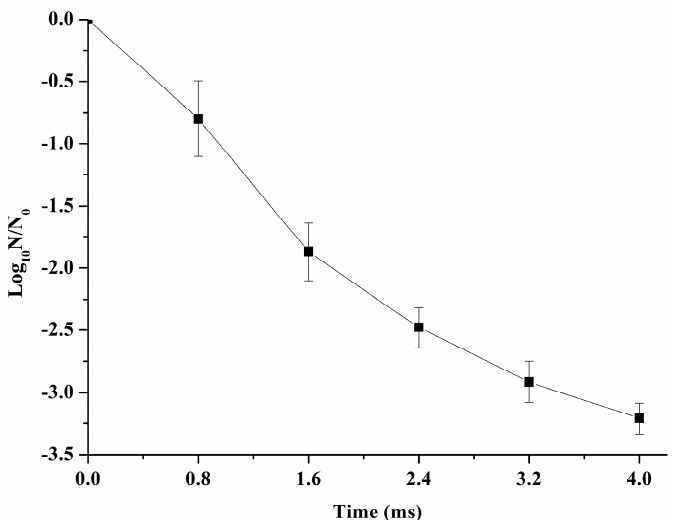
Figure 1. The inactivation of Salmonella typhimurium ( S. typhimuriumi ) by pulsed electric field (PEF) treatment at 25 kV/cm for 0–4 ms.